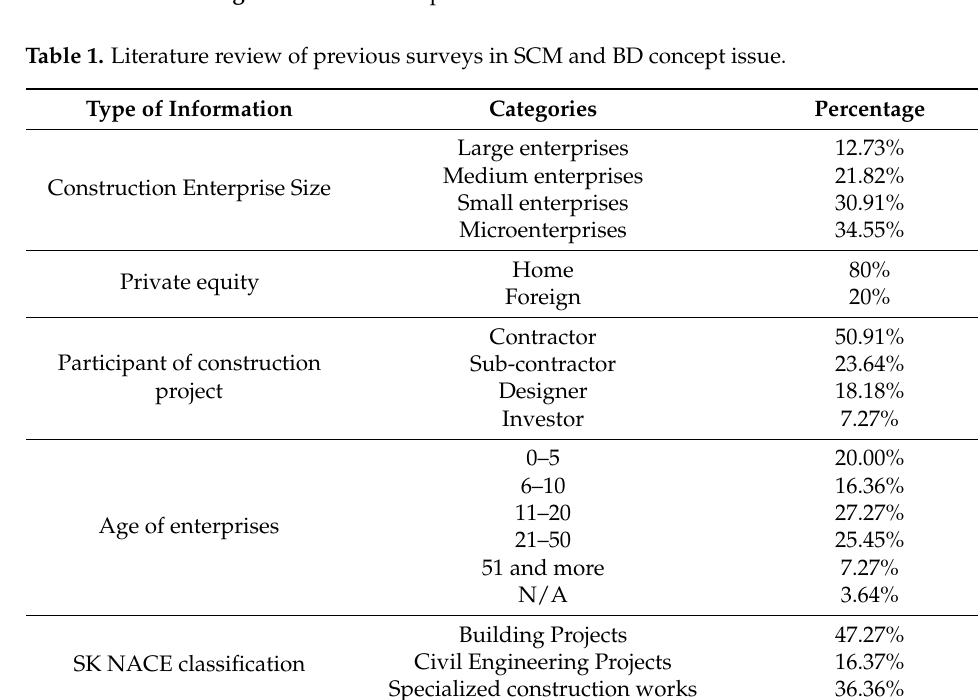
Table 1. Literature review of previous surveys in SCM and BD concept issue.